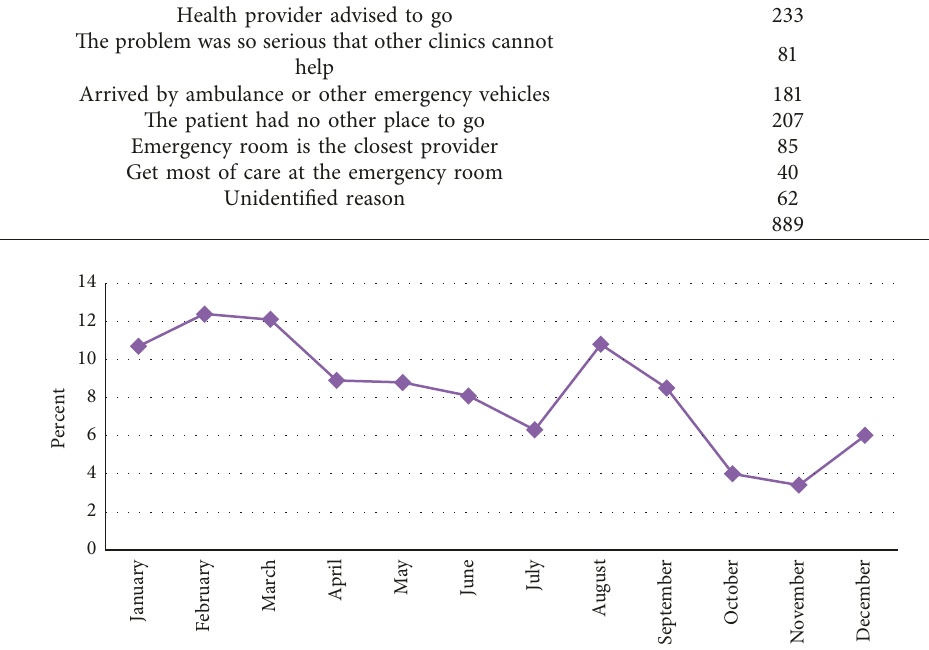
Figure 1: Patterns of adult emergency department admissions in Nekemte, western Ethiopia,